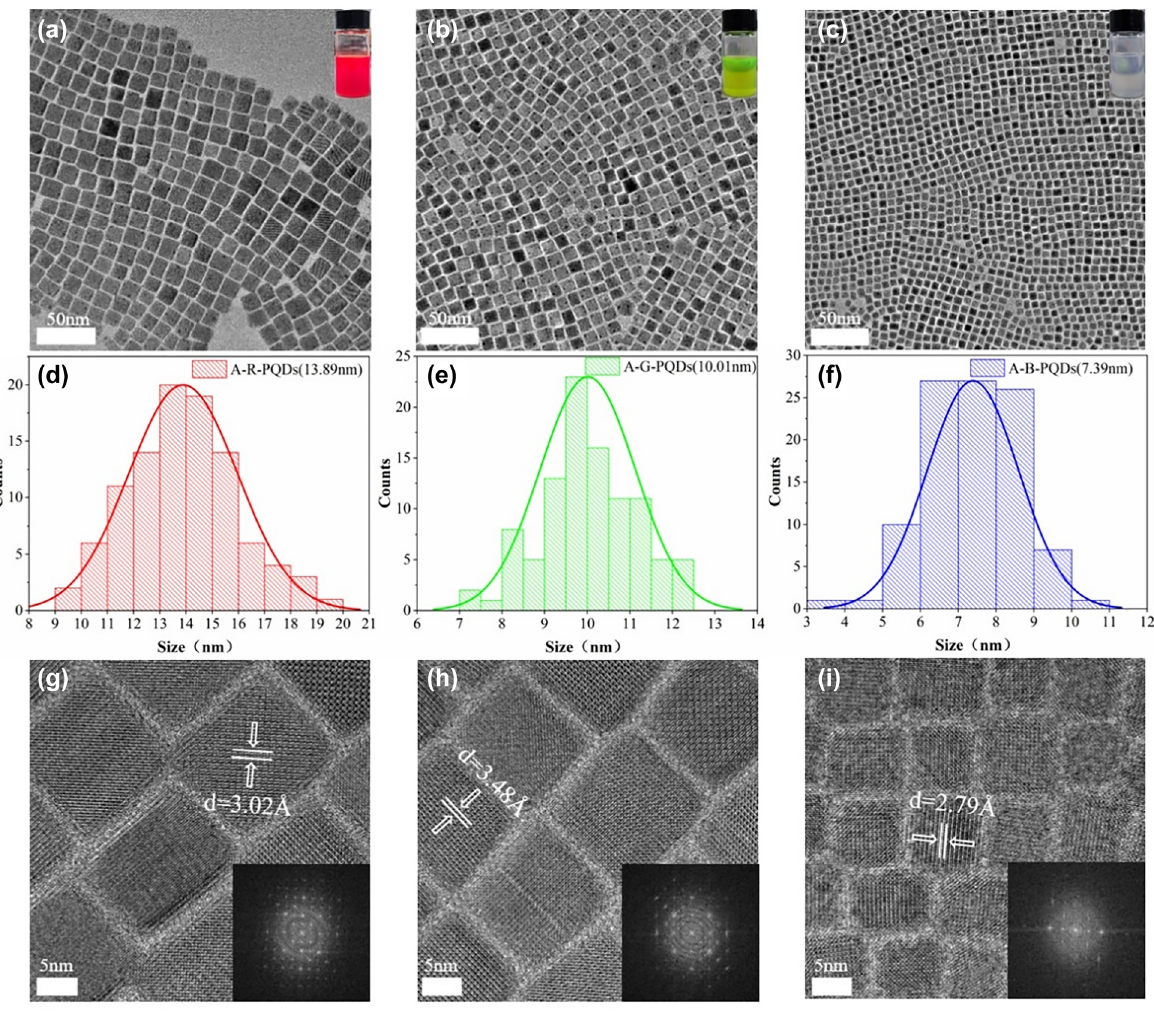
Figure 4: TEM images of (a) A-R-PQDs, (b) A-G-PQDs, and (c) A-B-PQDs; particle size distribution statistics of (d) A-R-PQDs, (e) A-G-PQDs, and (f) A-B-PQDs; high-resolution TEM images and crystal diffraction patterns of (g) A-R-PQDs, (h) A-G-PQDs, and (i)